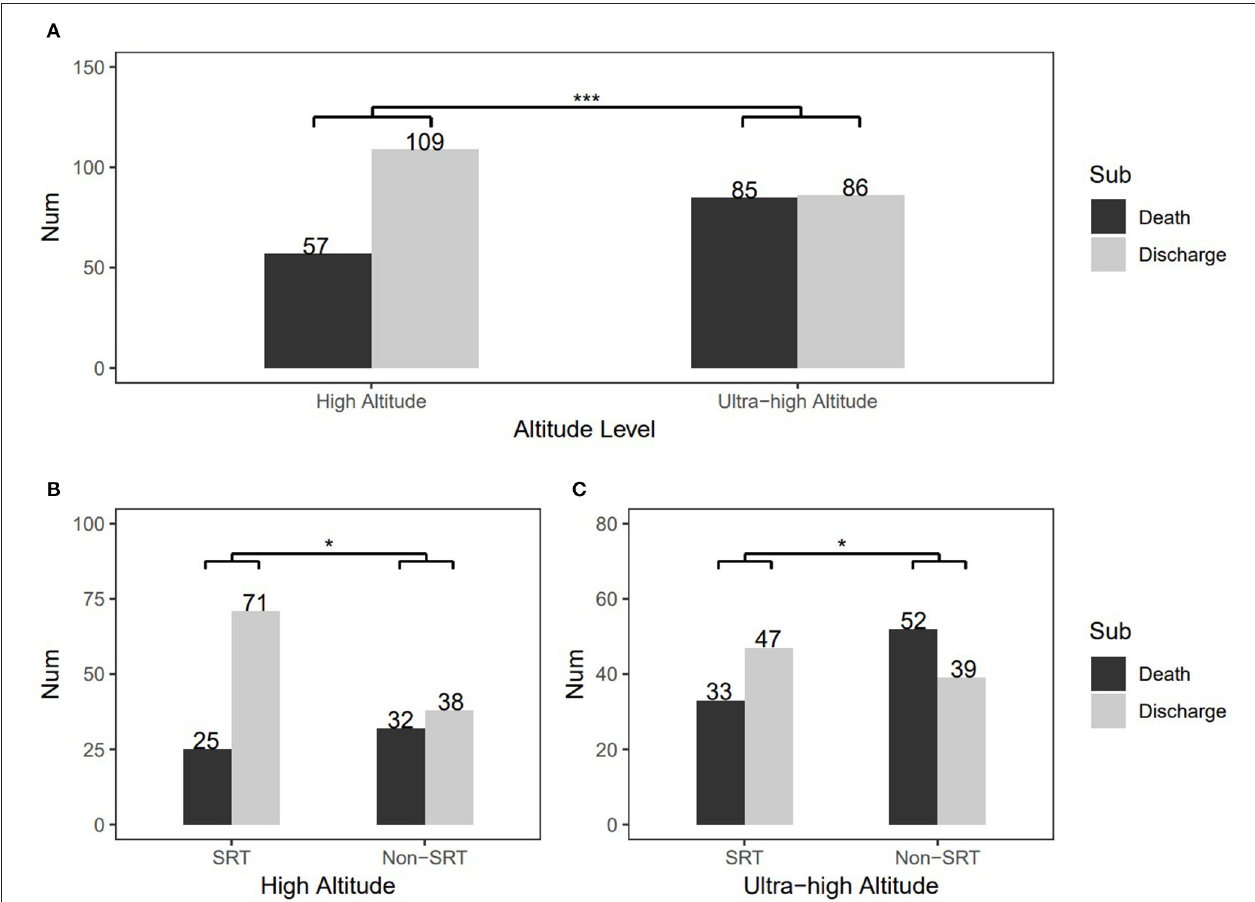
FIGURE 2 | Change in patients’ health status and comparisons of therapeutic effects of surfactant replacement therapy between the high-altitude and ultra-high-altitude groups. (A) Overall health status’changes at different altitudes, (B) Comparison of therapeutic effects of surfactant replacement therapy in the high-altitude group, and (C) Comparison of therapeutic effects of surfactant replacement therapy in the ultra-high-altitude group. The numbers on the graph represent frequency in the different subgroups. Sub, subgroups of various outcomes; SRT, surfactant replacement therapy; non-SRT, without using surfactant replacement therapy. *** P < 0.001 and *0.01 < P < 0.05 (chi-square